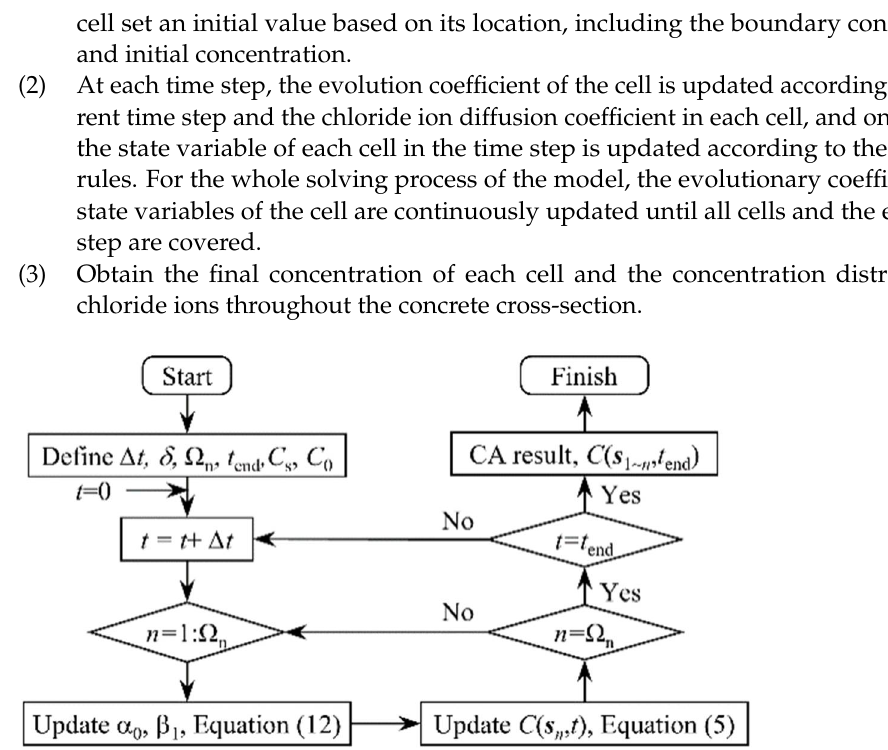
Figure 3. Calculation process and steps for the 3D CA model.